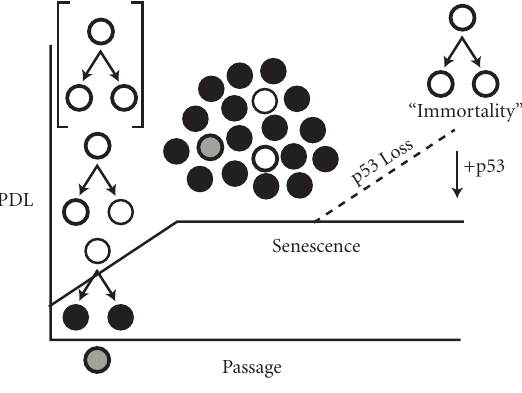
Figure 4: Asymmetric cell kinetics model for cellular senescence. Top,somatic tissue stem cell (bold-lined circles) turnover unit (TU). In vivo there are three stem cell kinetics states: highly regulated sym- metric kinetics that produce two stem cells (bracketed); dormancy (stippled circle); and asymmetric cell kinetics, the most populated stem cell kinetic state in most tissues [21–24]. TDN, the number of transit cell generations before terminal arrest (closed circles), varies in different tissues from 0.0 to n . 2 TDN = 0 . 5 × number of transit cells in the TU [24]. Bottom, the ex vivo continuation of in vivo asymmetric cell kinetics results in cellular senescence. Because symmetric stem divisions are rare and possibly proapoptotic [31], asymmetric TU kinetics predominate in culture. The dilution of asymmetric stem cells by accumulating nondividing terminal cells is responsible for the observed decline in population doubling rate. Loss of p53 function in cell culture prevents senescence by allowing asymmetric stem cells to divide symmetrically; resulting in the ex- ponential division that characterizes immortalization. In support of this model, reconstitution of normal p53 function in immortal cells restores asymmetric cell kinetics and senescence. PDL, cumulative population